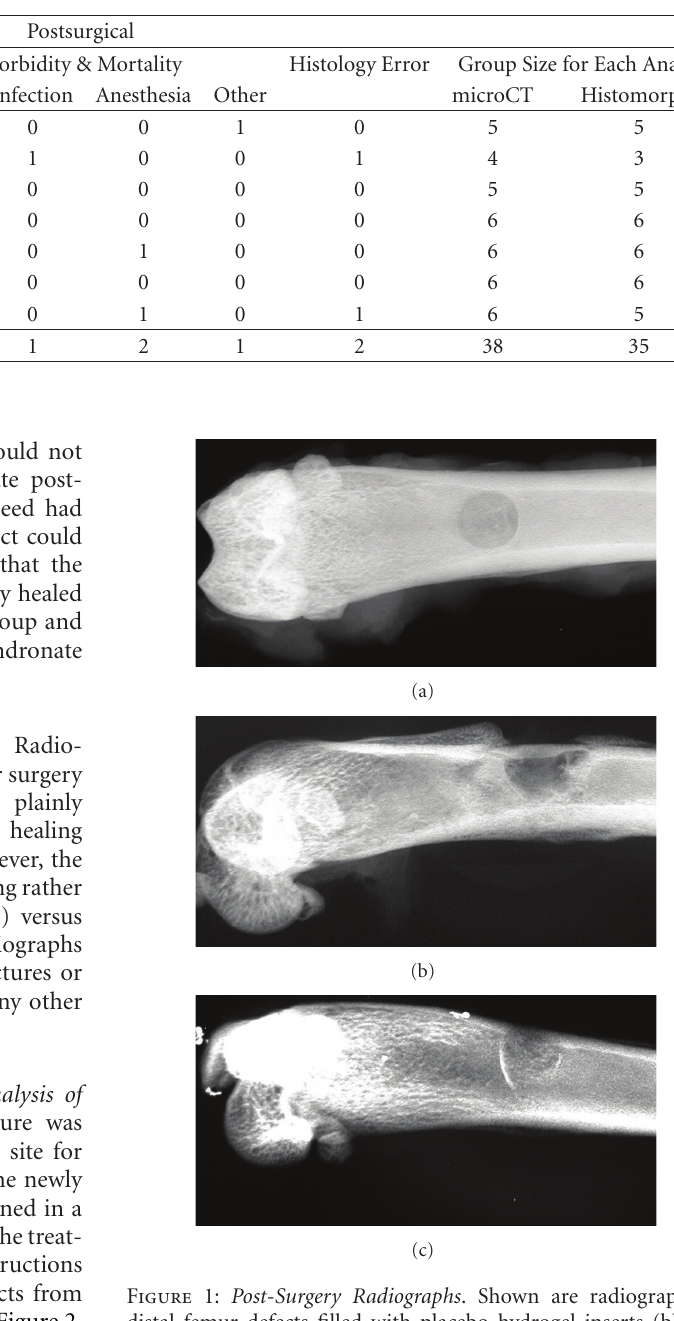
no di ff erence was found between the low- and high-dose alendronate groups ( P =